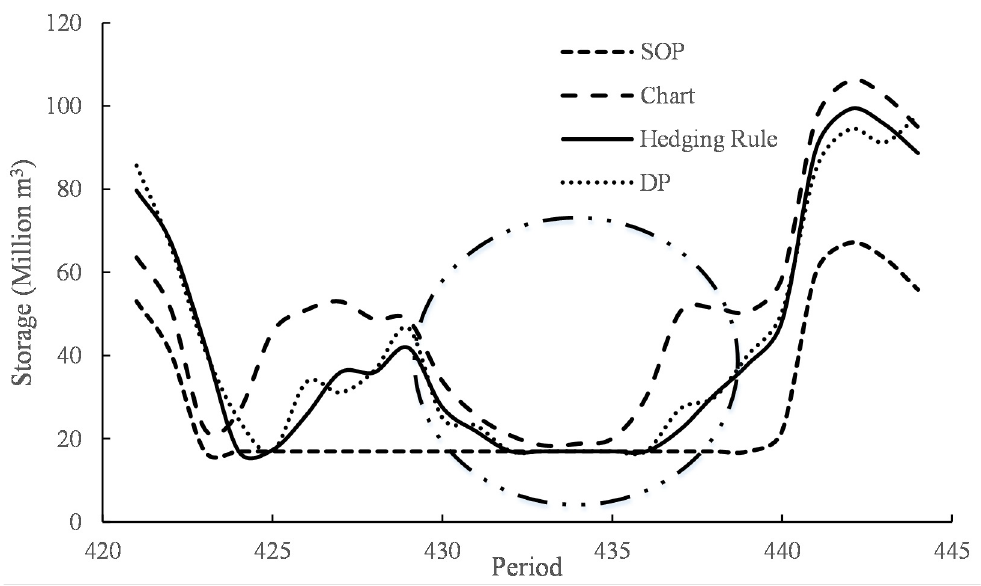
Figure 8. Scheduling results for different scheduling scheme in Period 421–444.